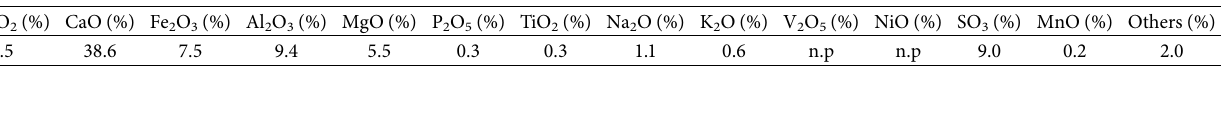
Table 2: Participation in % of elements in the fly ash of the Kosovo A power plant.